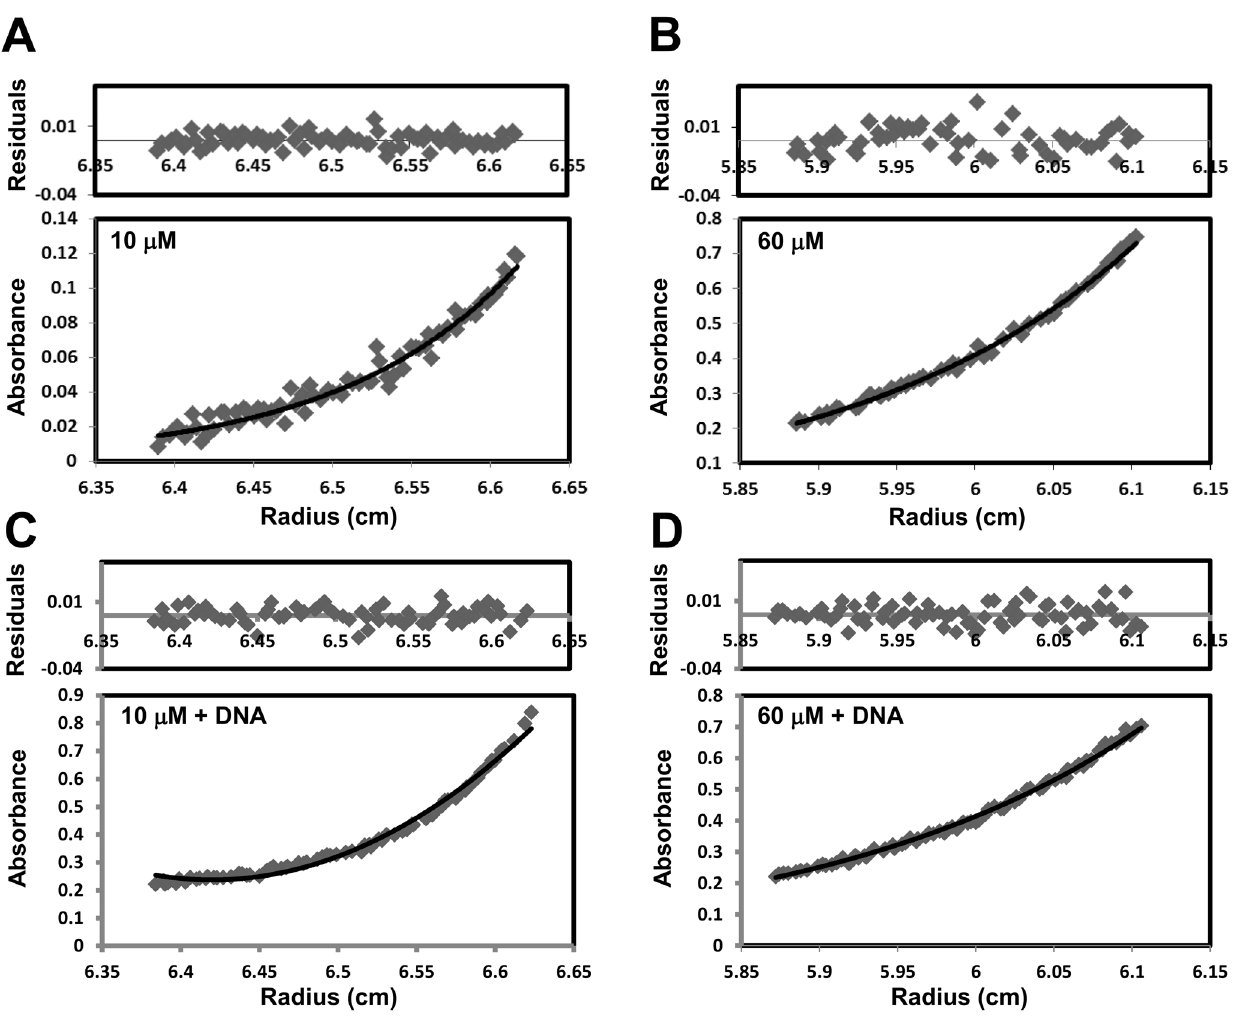
Figure 5. Sedimentation equilibrium analysis of INI1 DBD and INI1:DNA complex. (A) Representative sedimentation equilibrium (SE) profiles of 10 m M (A) and 60 m M (B) of INI1 DBD generated from data collected at 280 nm. Representative sedimentation equilibrium (SE) profiles of a reaction mixture of 10 m M INI1 DBD and 10 m M U5 HIV-1 LTR DNA diluted 1:7.5 x with buffer (C) and a reaction mixture of 60 m M INI1 DBD and 60 m M U5 HIV-1 LTR DNA diluted 1:40 x with buffer (D) generated from data collected at 260 nm. Lower panels: Radial distribution of the concentration of INI1 DBD (A and B) and DNA (C and D) both free and in complex with INI1 DBD at sedimentation equilibrium. The solid line represents best fit. Upper panels: Distributions of the residuals around a zero mean. doi:10.1371/journal.pone.0066581.g005 (protein:DNA) and at high protein concentration the INI1 DBD 13613 Da. At low protein concentration (i), the molecular mass dimer binds to DNA with a stoichiometry of 1:2 (protein:DNA). 25415 6 510 Da corresponds to one molecule of the DBD monomer bound to one molecule of the DNA whereas the molecular mass 36287 6 129 Da corresponds to two molecules of Isothermal Calorimetry of INI1 DBD Binding to DNA the monomer bound to one molecule of DNA (Table 1). At high Isothermal calorimetry (ITC) is a powerful technique for protein concentration (ii), the molecular mass 36992 6 504 Da monitoring protein-DNA binding. Not only does it allow precise corresponds to one molecule of the dimer bound to one molecule measurement of dissociations constants, but also it allows of DNA and the molecular mass 50281 6 769 Da corresponds to simultaneous measurement of the entropy and enthalpy changes one molecule of dimer bound to two molecules of DNA (Table 1). associated with the binding process. ITC experiments were carried The molecular masses 15422 6 1438 Da (i) and 16628 6 1193 Da out using purified recombinant INI1 DBD and the U5 HIV- (ii) correspond to the free DNA. The higher molecular mass of free 1 LTR DNA (Figures 6A and 6B) at two different protein DNA is due to the fact that the partial specific volume of the concentrations (10 m M of monomer and 30 m M of dimer). The protein-DNA complex (0.6478 ml/gm and 0.6691 ml/gm), rather DNA concentration in the syringe was kept at 5.5 x and 11 x the than DNA alone (0.59 ml/gm), was used to fit the data. In concentration of 10 m M of monomer and 30 m M of dimer, summary, our data suggests that at low protein concentration the respectively. The raw and fitted data are shown in Figures 6A and INI1 DBD monomer binds to DNA with a stoichiometry of 2:1 6B, respectively. Data was fitted with different binding models viz one-site, two-site and sequential binding sites. At a protein